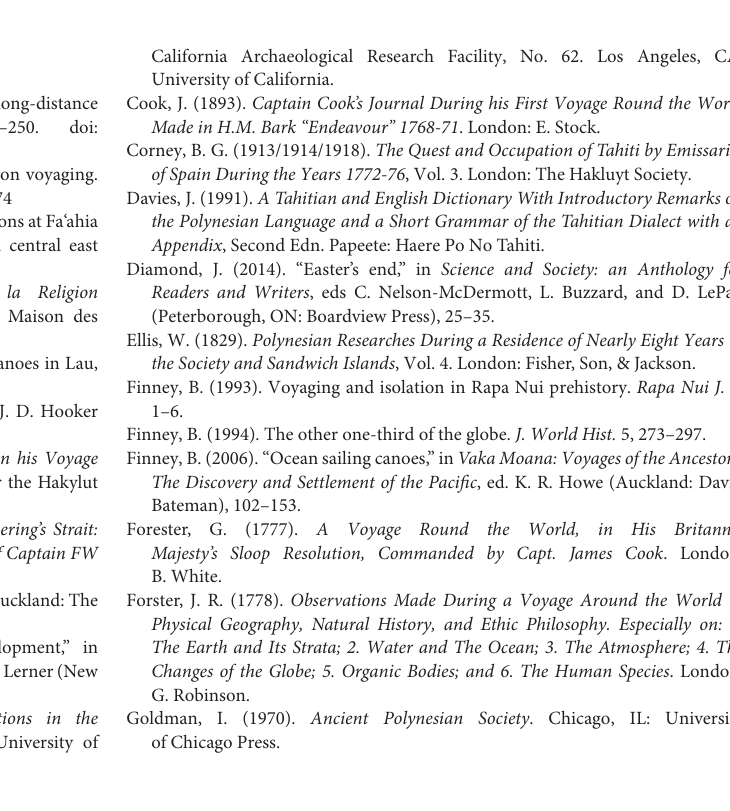
Supplementary Table 1 | Use Categories for Human-Centered Interaction Networks database. Entries after Verhagen et al. (2021, Table 2 ), excepting Cosmology, which is specific to the Society Island-Gambier Island HCIN databases and Ornamental, whose meaning has been modified in the current paper. Supplementary Table 2 | Canoe Network Node Data Used in the Network Analysis. Supplementary Table 3 | Details of select Eastern Polynesian societies and canoe types at the time of European Contact, after Forester, 1777; Wilkes,